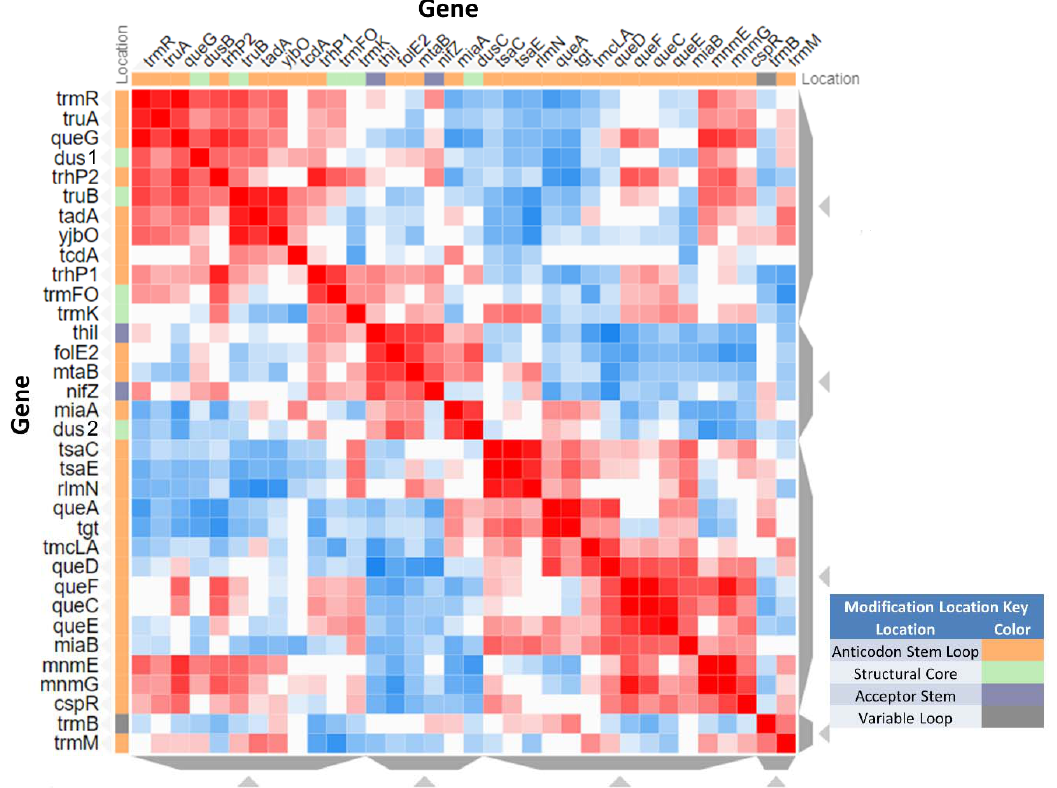
Figure 5. Fitness Data Similarity Matrix for predicted tRNA modification genes. The fitness scores for the ErmR mutant set are displayed as a similarity matrix, with the deleted gene shown on each of the axes of the matrix. The position of the tRNA modification that each gene mediates is denoted by the colored box next to each gene’s name. Fitness scores with similar values are shown in red while dissimilar scores are shown in blue. The full dataset is given in Table S4.